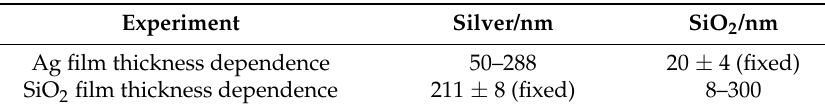
Table 1. Each film thickness prepared for each